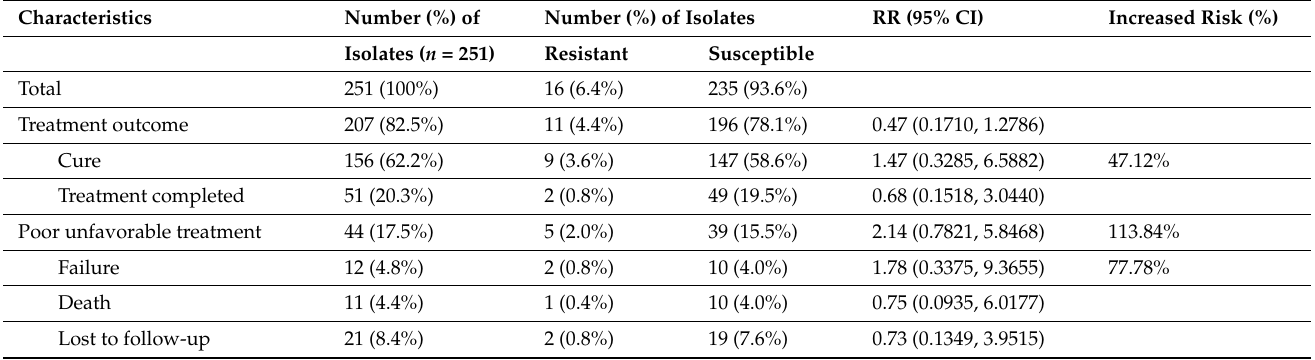
Table 5. Multivariate analysis of treatment outcomes pre-XDR-TB among multidrug-resistant/ rifampicin mono-resistant and isoniazid mono-resistant tuberculosis patients ( n =